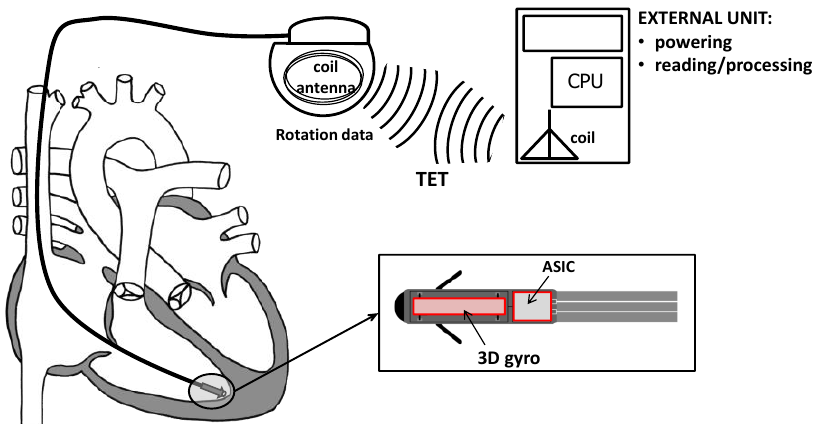
Figure 1. Scheme of conceptual design of the CardioMon lead system for continuous monitoring of cardiac apex rotation.